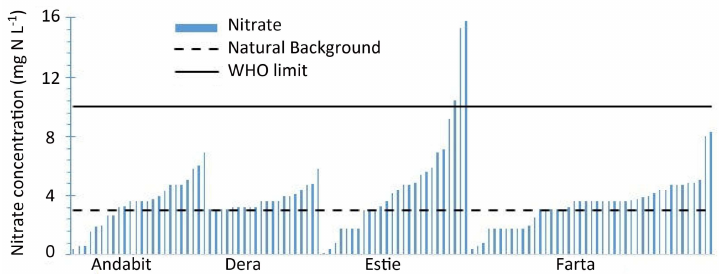
Figure 3. Nitrate concentration in wells and springs in the agricultural lands of Andabit, Dera, Estie, and Farta woredas in South Gondar,